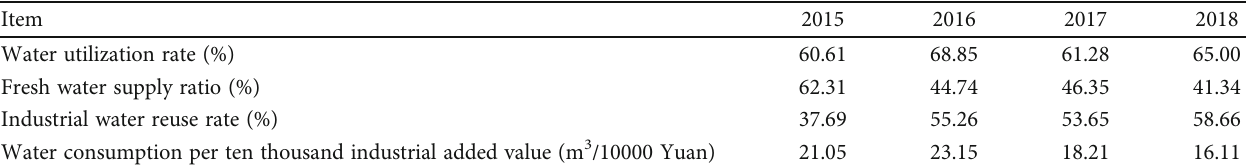
Table 8: The value of water resource consumption index.